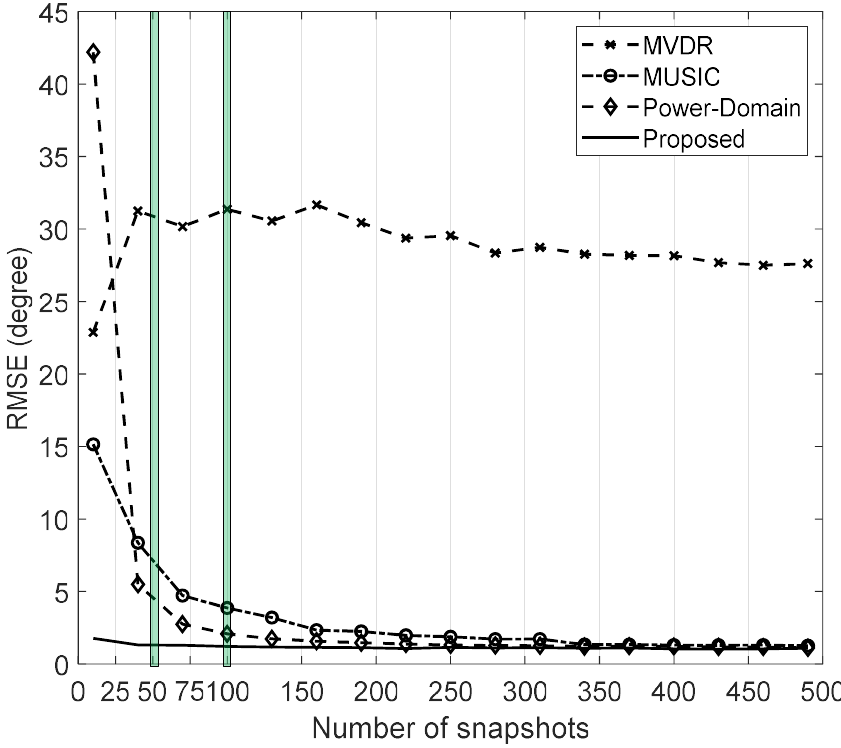
Figure 3. RMSE versus the signal-to-noise ratio (SNR) for the different estimators (MUSIC, MVDR, Power-Domain, and the proposed estimator) in Example 1.